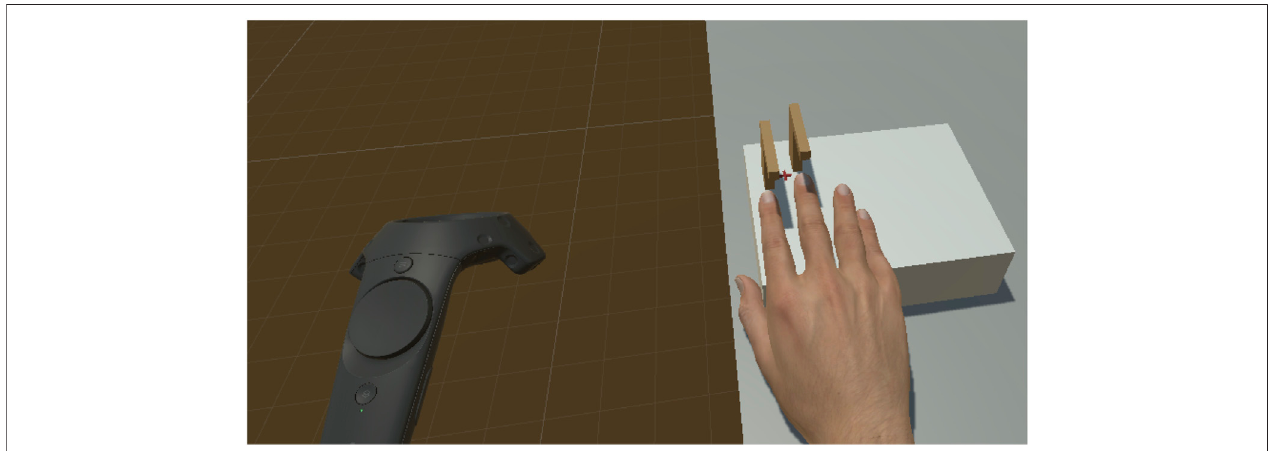
FIGURE3| Thevirtualsceneviewedfromthe fi rstpersonperspective;duringthetask,participantshadtolookattheredcrosslocatedonthesurfacebetweenthe index and middle fi ngers.